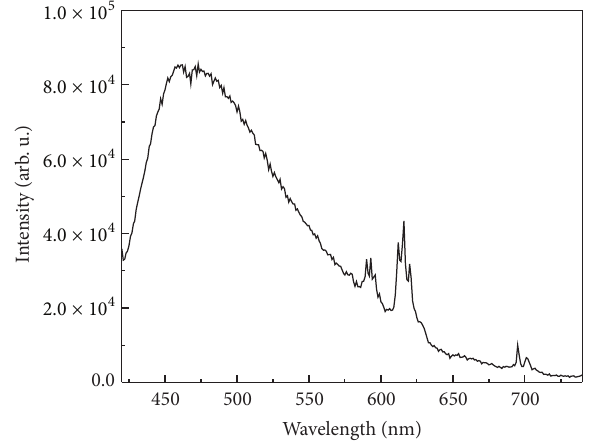
Figure 2: Photoluminescence emission spectrum of synthesized CaSO 4 :Eu (Eu 0.5